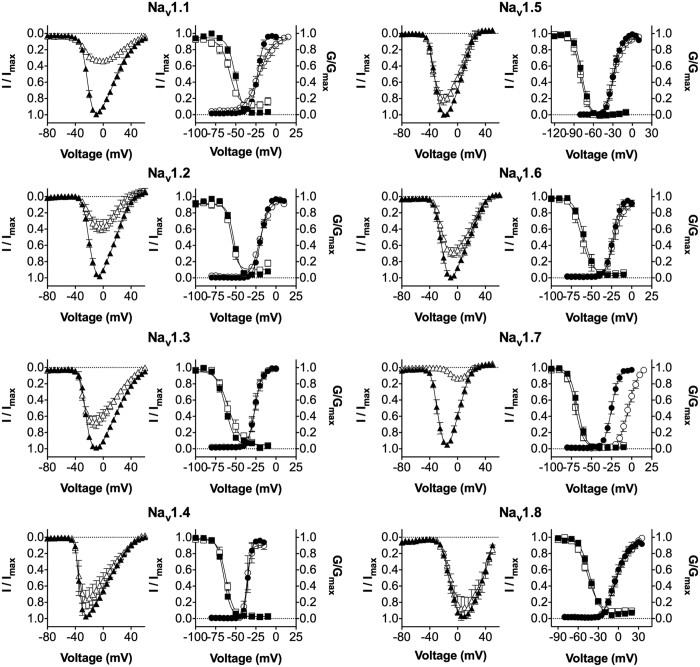
Effect of μ-TRTX-Pn3a on the electrophysiological parameters of hNaV1.1-1.8.I-V curves before (black triangles) and after addition of Pn3a (white triangles). Pn3a (100 nM) inhibited peak current at all NaV subtypes but caused a rightward shift in the I-V curve at NaV1.7 only. G-V curves before (black circles) and after addition of Pn3a (white circles). Pn3a (100 nM) significantly shifted the V1/2 of voltage-dependence of activation to a more depolarized potential at NaV1.7 only (Δ + 21.3 mV). Voltage-dependence of steady-state fast inactivation curves before (black squares) and after addition of Pn3a (white squares). Pn3a (100 nM) caused small but significant shifts in the V1/2 of steady-state fast inactivation at NaV1.1, 1.2, 1.3, 1.4, 1.7 and 1.8. Data are presented as mean ± SEM, with n = 4–10 cells per data point.